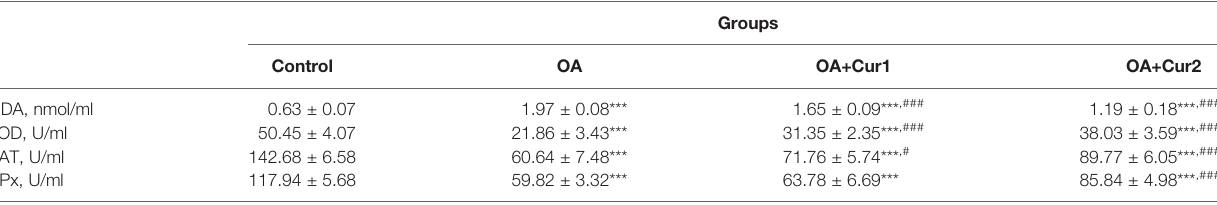
TABLE 4 | Effects of NGUC supplementation on serum levels of MDA and antioxidant enzymes in rats with monosodium iodoacetate (MIA)-induced OA.